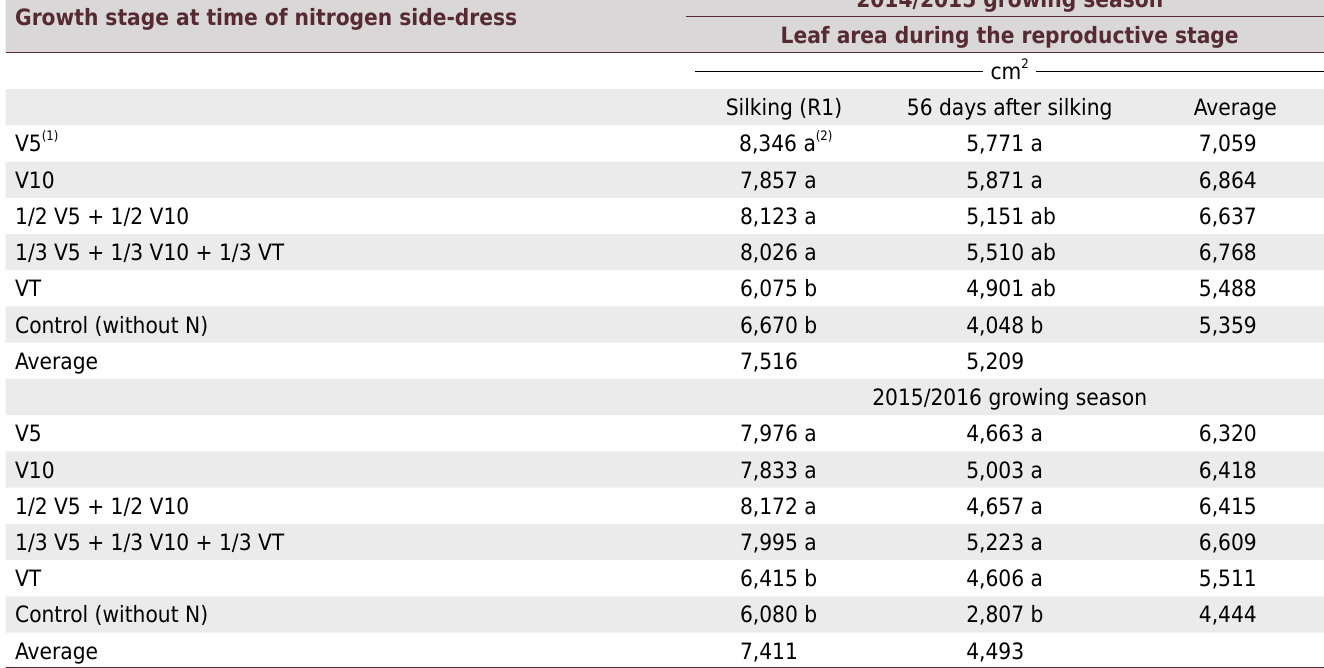
(1) V5 = five expanded leaf stage; V10 = ten expanded leaf stage; VT = tasseling, according to the growth stage scale proposed by Ritchie et al. (1993). Single application rate of 300 kg ha -1 N. (2) Averages followed by the same lowercase letter in the column do not differ significantly by the Tukey test at the significance level of 5